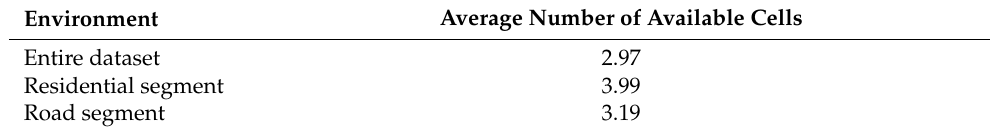
Table 2. Average number of available cells.